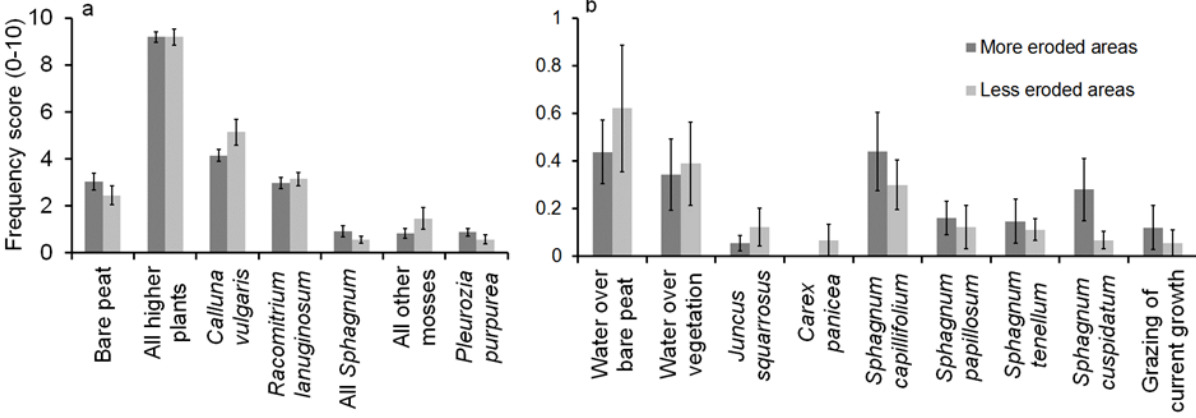
Figure 4. Fine-scale vegetation data from the study area: frequency scores of (a) common and (b) rarer plants and other features, by survey stratum (mean and s.e.).